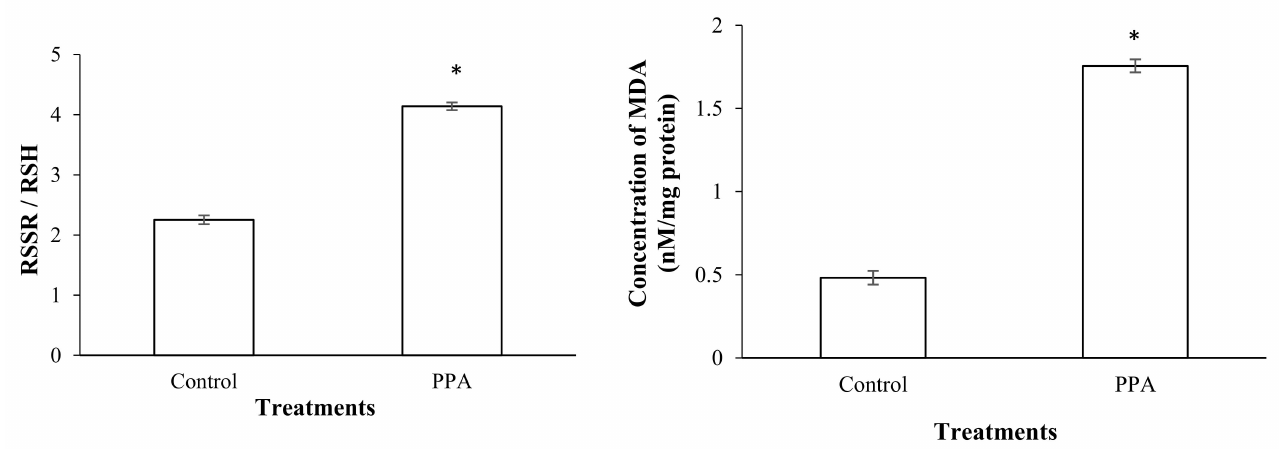
Figure 6. Ratio of oxidized to reduced thioles (RSSR/RSH) and MDA concentration in control and PPA-treated adults of Sitophilus oryzae . Statistical differences have been marked by asterisks ( t -test, p ≤ 0.05). * indicate significant